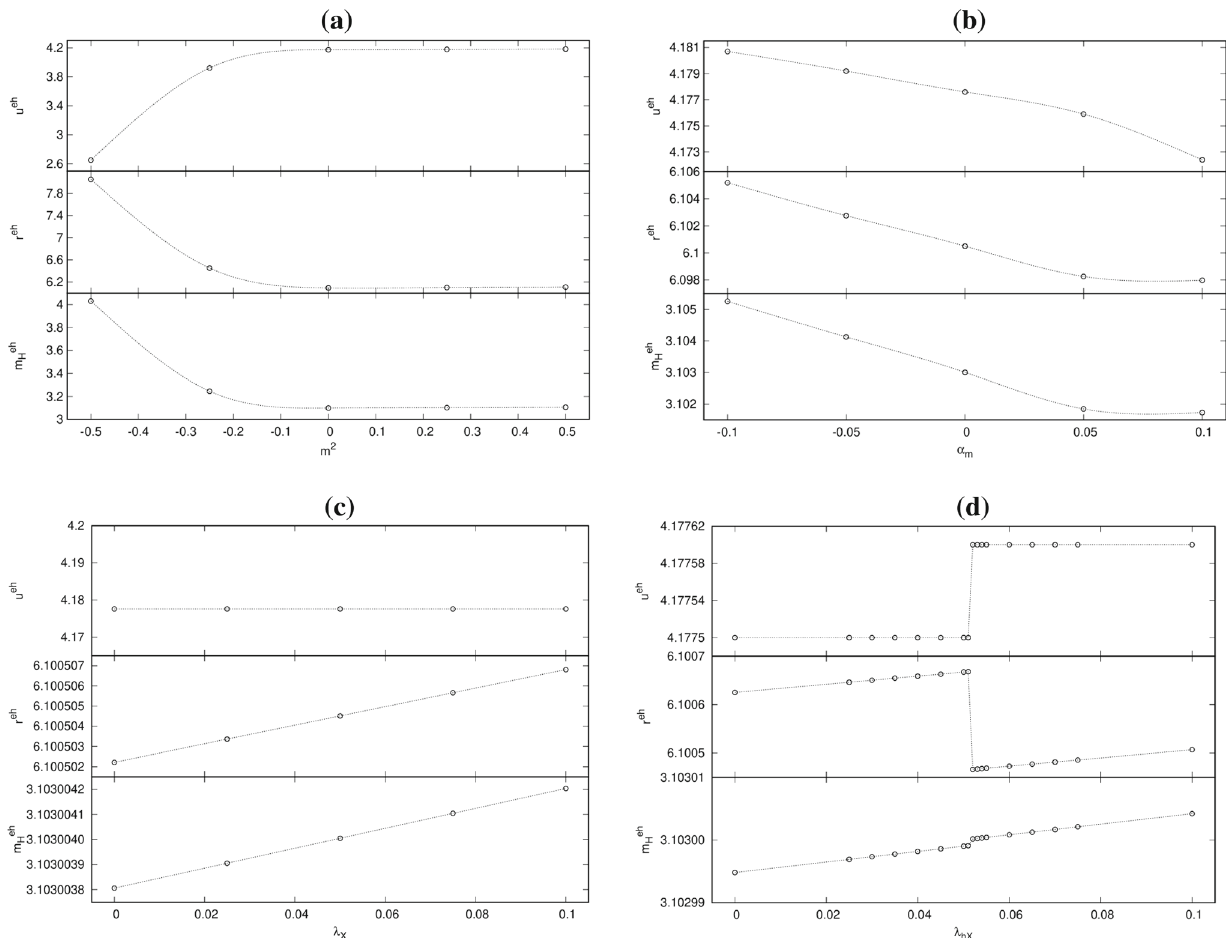
c λ X and d λ hX . The non-varying parameters were λ X = λ hX = 0 . 1, m 2 = 0 . 25, ξ X = ξ h = 0, α m = 0, ˜ p X = ˜ p h = 0 .